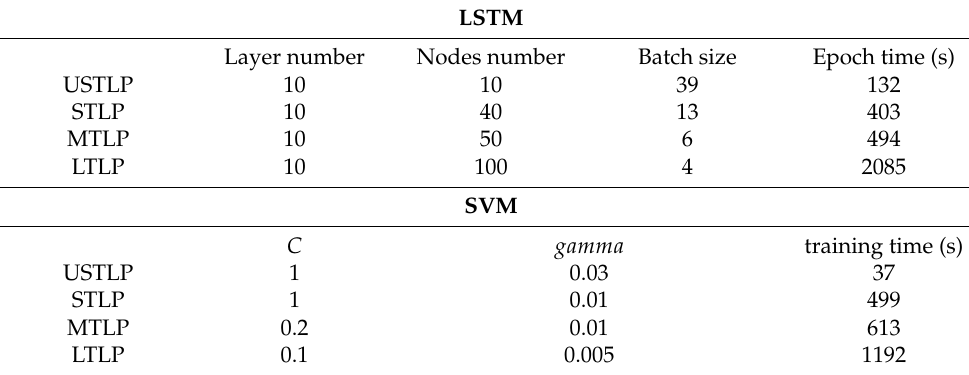
Table 1. Model parameters and training/epoch time for LSTM and SVM.